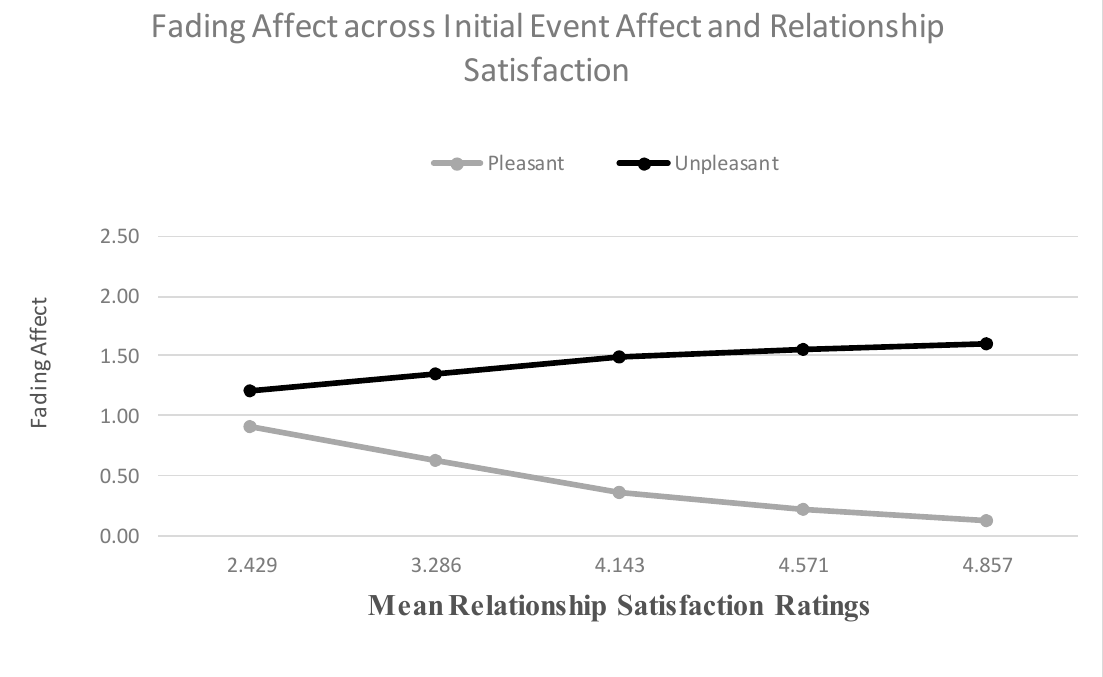
Figure 5. Fading affect for pleasant and unpleasant events across quintile levels (10th through 90th) of relationship satisfaction.